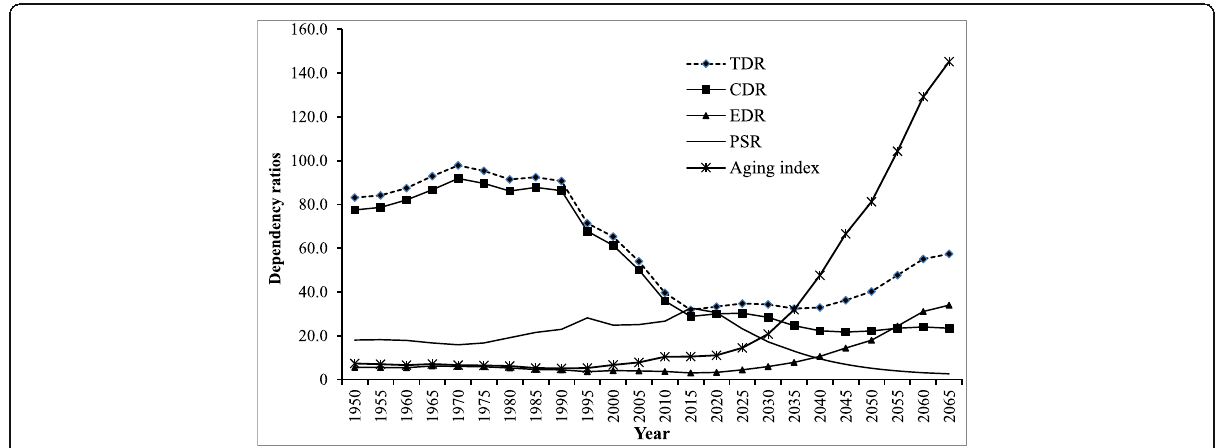
Fig. 7 Dependency ratios, potential support ratio and aging index, 1950 – 2065. Source: UN population estimates and projection [27]